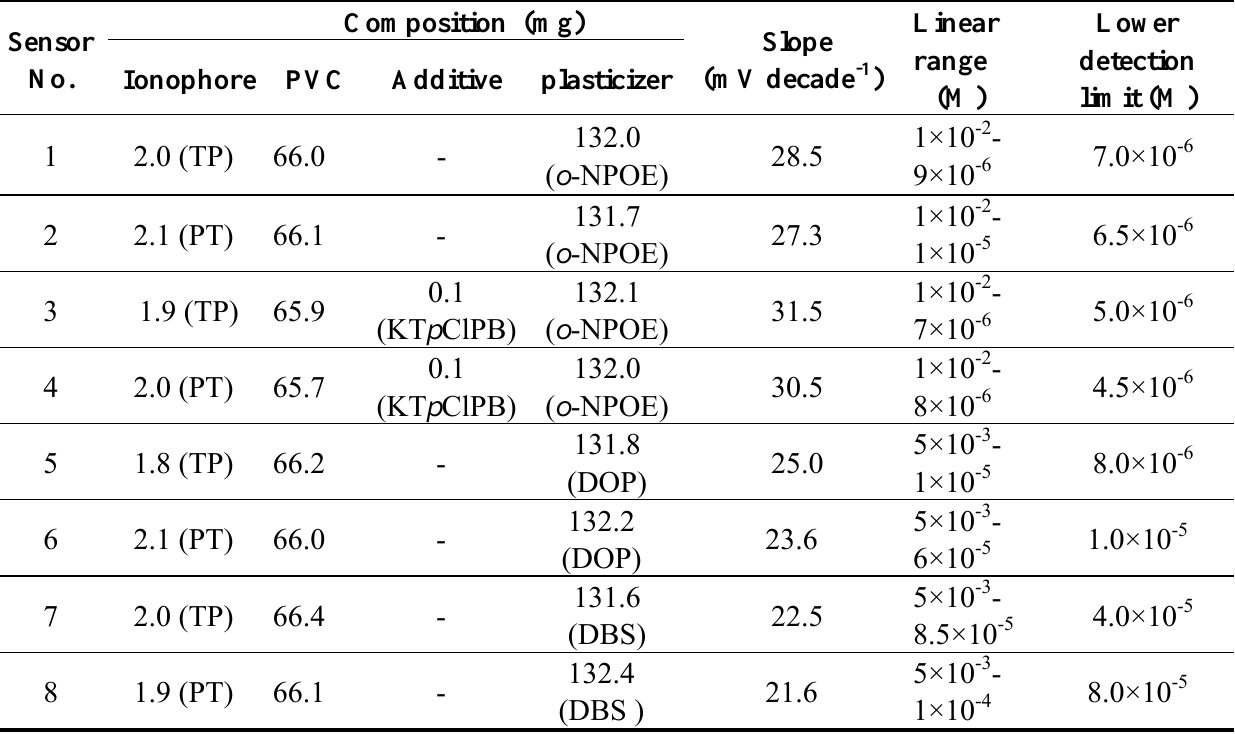
Table 1. Optimization of membrane